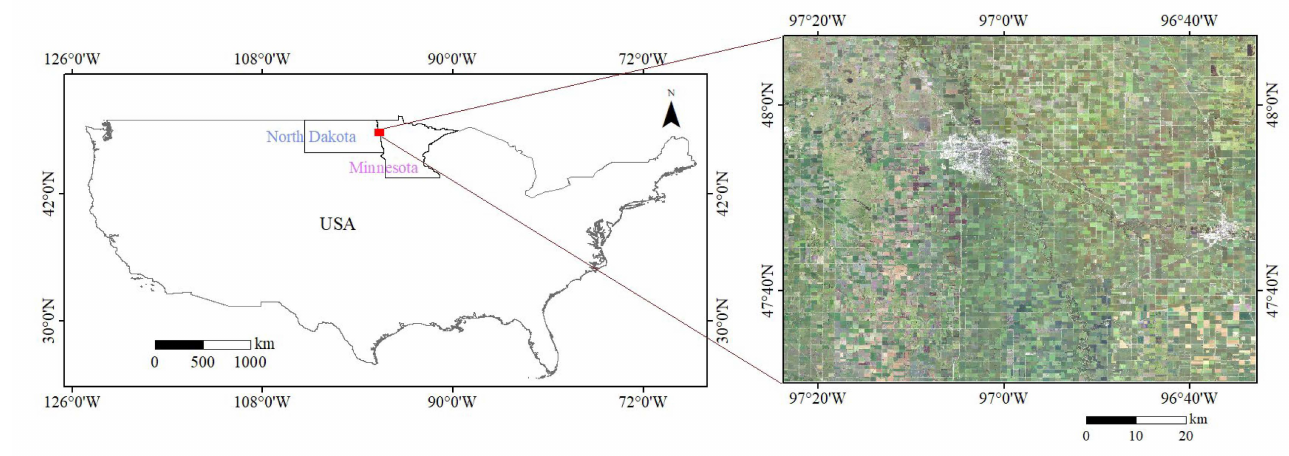
Figure 1. Location of study area. The RGB true color composite image was from the 2018 NAIP